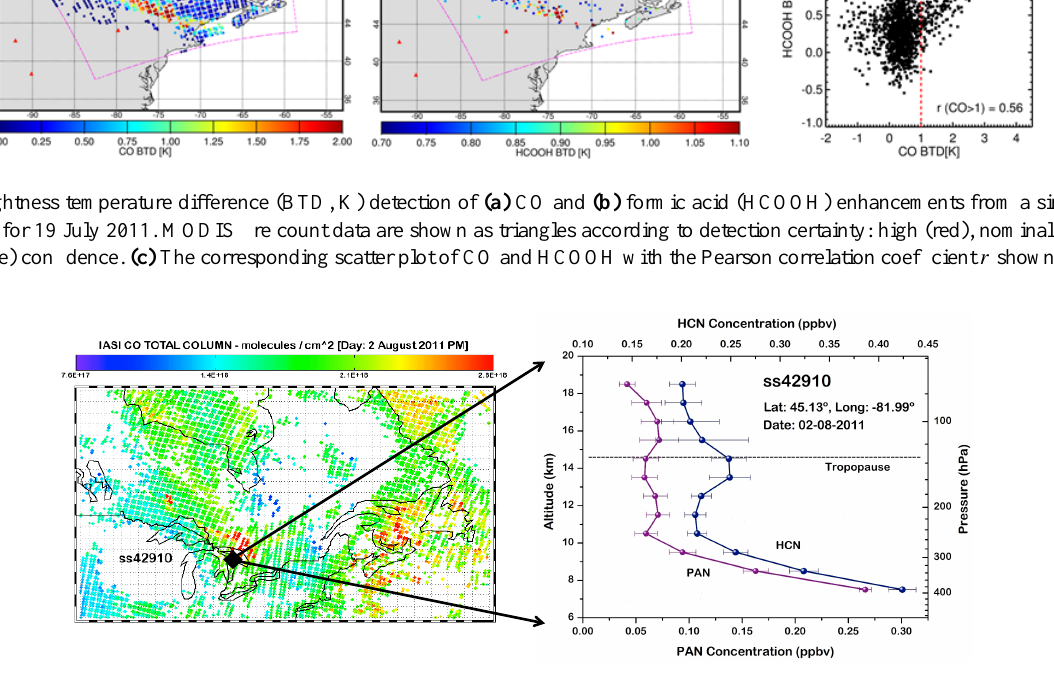
Fig. 11. Left: IASI total column CO (moleccm − 2 ) for 2 August 2011. The black diamond superimposed denotes the position of occultation ss42910 from the ACE space-borne sensor. Right: vertical profiles of HCN (ppb) and PAN (ppb) from ACE during occultation ss42910 (45.13 ◦ N, − 81 . 99 ◦ W).